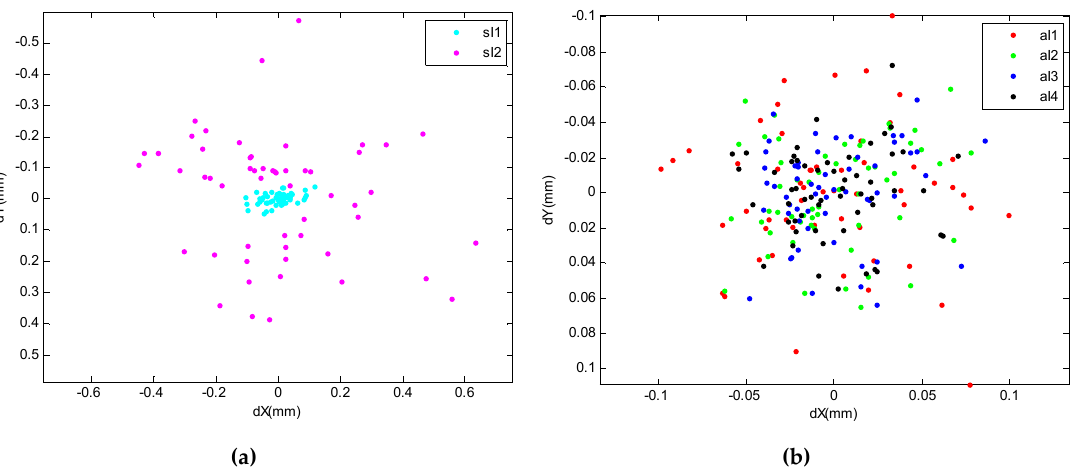
Figure 26. Coordinates differences between mapped and actual chessboard world coordinates of chessboard corners. (a) The coordinates differences in two experiments of simulated cable images; (b) The coordinates differences in four experiments of actual cable images.